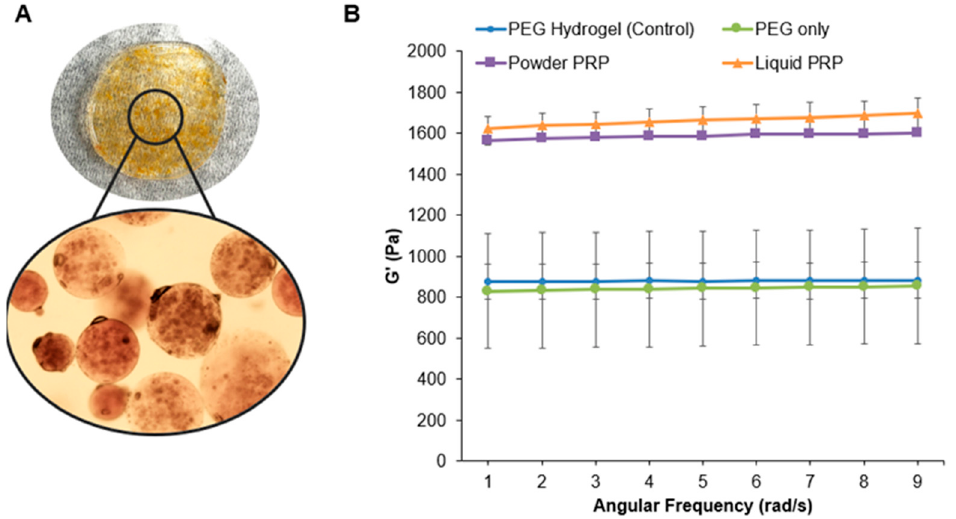
Figure 5. Storage moduli of microspheres as a function of PRP loading. ( A ) Representative images of powder PRP-loaded microspheres encapsulated in a bulk PEG hydrogel (10% w/v in PEG) for rheology measurements. ( B ) Representative data for storage moduli of microspheres as a function of PRP loading (n=3). Microspheres were prepared with 4-arm PEG–Ac and PEG–diSH as a crosslinker at 10% w/v in PEG. Powder and liquid PRP were loaded at 10% w/v.